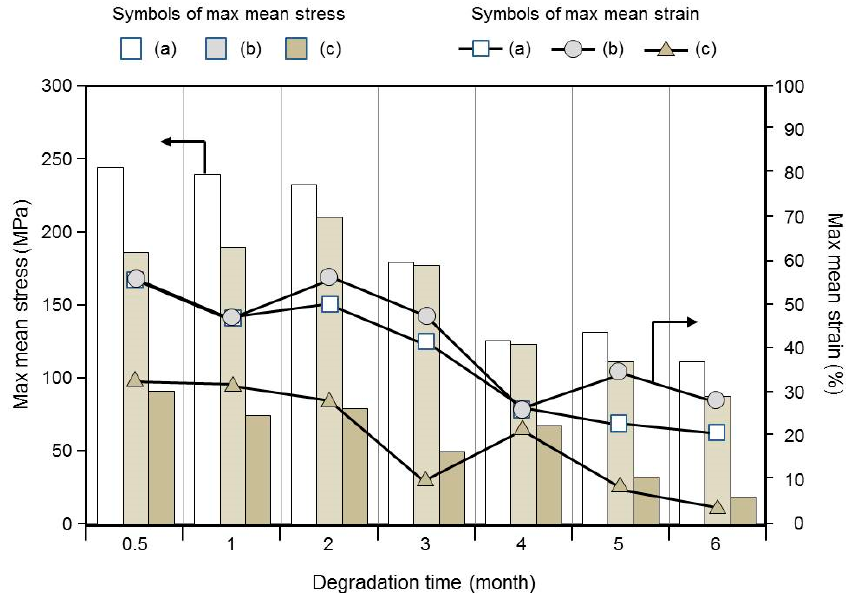
Figure 9. Max mean stress (MPa) and strain (%) of degraded PLA fibers: ( a ) original PLA fiber; ( b ) P-3 and ( c )